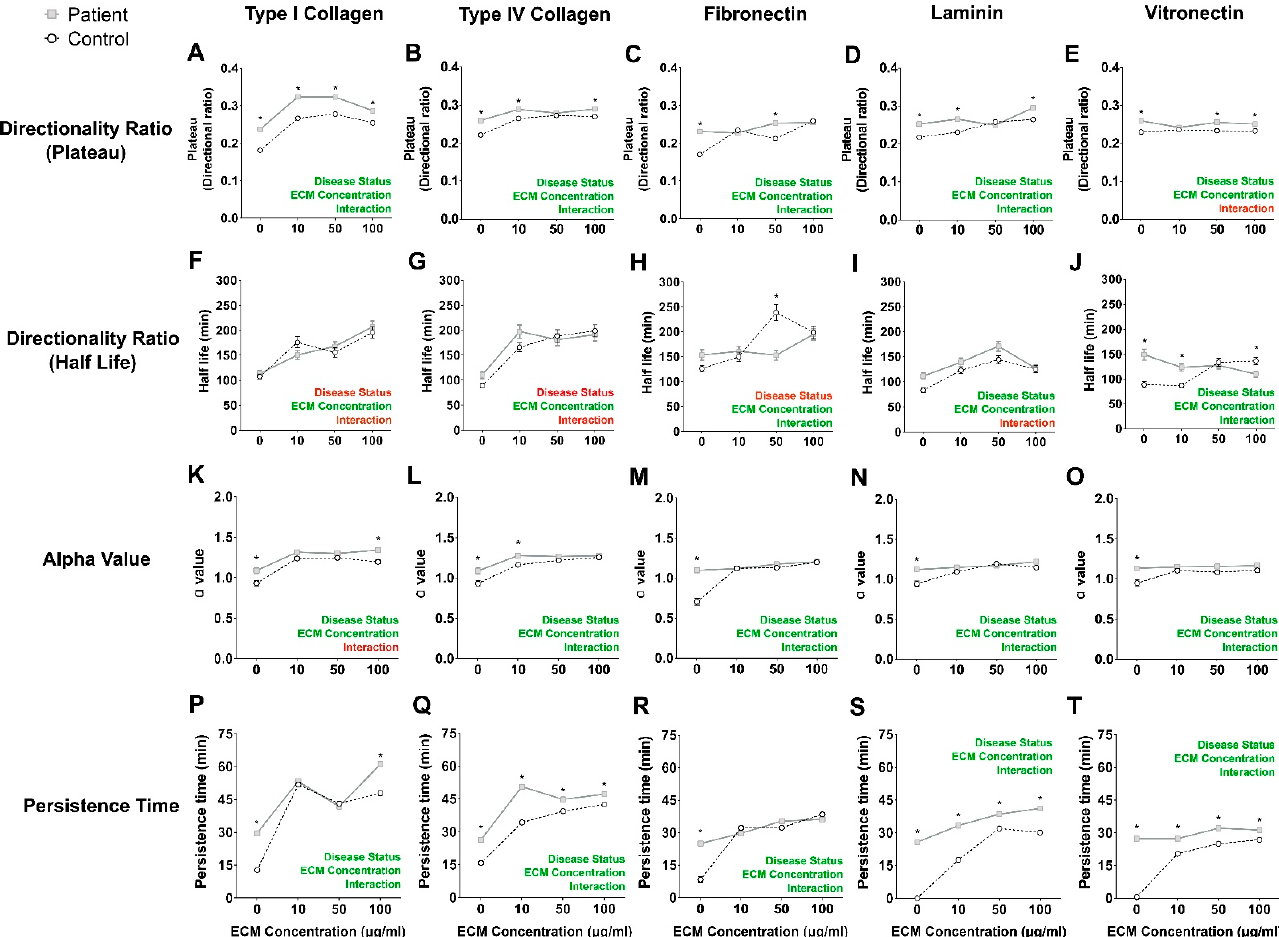
Figure 3. Patient cell migration is more persistent than control cell migration on most ECM protein substrates. ( A – E ): Directionality Ratio Plateau values for patient and control cells migrating on the ECM proteins at different concentrations. ( F – J ): Directionality Ratio Half-life values for patient and control cells migrating on the ECM proteins at different concen- trations. ( K – O ): MSD α -values for patient and control cells migrating on the ECM proteins at different concentrations. ( P – T ): Persistence times for patient and control cells migrating on the ECM proteins at different concentrations. All data are presented as the mean track distance ± SEM. Control cells: open circles with black dotted lines ( n = 9 independent cell lines). Patient cells: closed grey squares with grey solid lines ( n = 9 independent cell lines). Two-way ANOVA was used